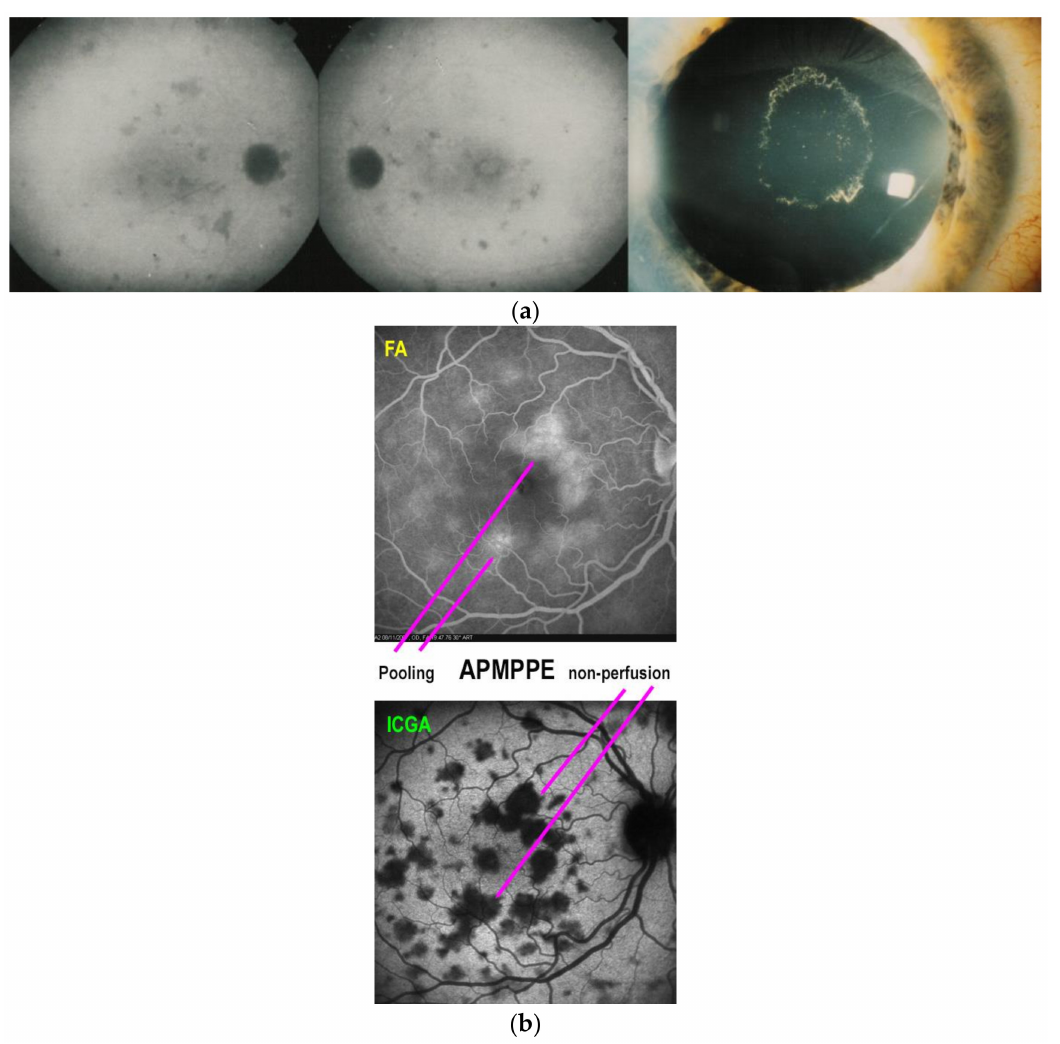
Figure 9. ( a ) Case of APMPPE/AMIC with associated anterior uveitis. This patient presented with a bilateral non-granulomatous anterior uveitis with synechiae ( right picture), a rare occurrence in APMPPE. The fundus showed bilateral placoid yellow lesions in the posterior pole (not shown) and discreet areas of ICGA hypofluorescence ( left and middle pictures) that resolved without scars (not shown) following a short course of 40 mg of prednisone, tapered over 5 weeks. ( b ) Late FA pooling in a severe case of APMPPE/AMIC. In severe cases of APMPPE/AMIC, FA shows areas of abundant retinal pooling in the late angiographic phase ( top picture). Traditionally this phenomenon is explained by the very hypothetical alleged change of polarity of the RPE and fluid movement from the choroid to the retina. However, the choriocapillaris areas under the retinal pooling are non-perfused ( bottom picture). Therefore, a more probable origin of the fluid is exudation from retinal vessels in response to severe outer retinal